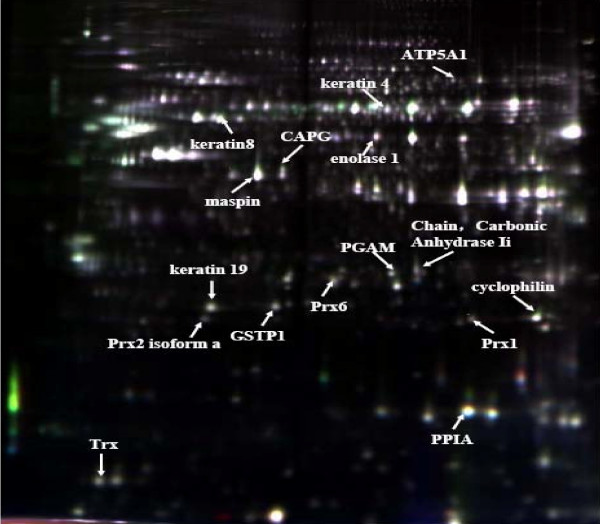
A representative 2D-DIGE image of the whole lysate of HaCaT cells exposed to 15-nm, 30-nm or micro-sized SiO2 particles at 10 μg/mL. The denoted protein spots were those altered by SiO2 exposure and identified by MS. The differentially expressed proteins were quantitatively analyzed and were listed in Table 2 along with protein identifiers.